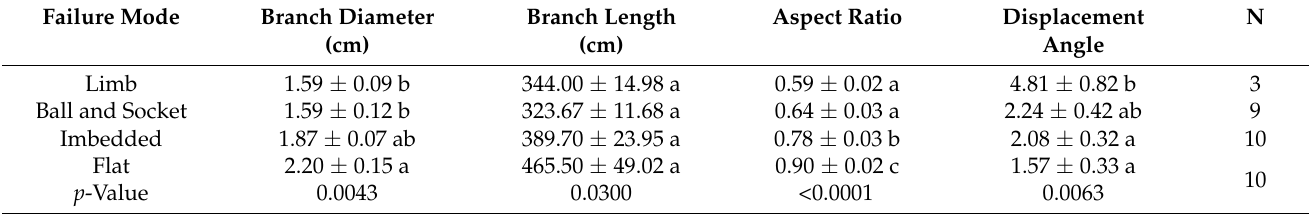
Table 1. Summary of branch morphology measurements. Mean ( ± SE) for branch diameter, length, aspect ratio, and separation angle (failure angle − initial angle). Means with different letters in the column were found to be significantly different using Tukey